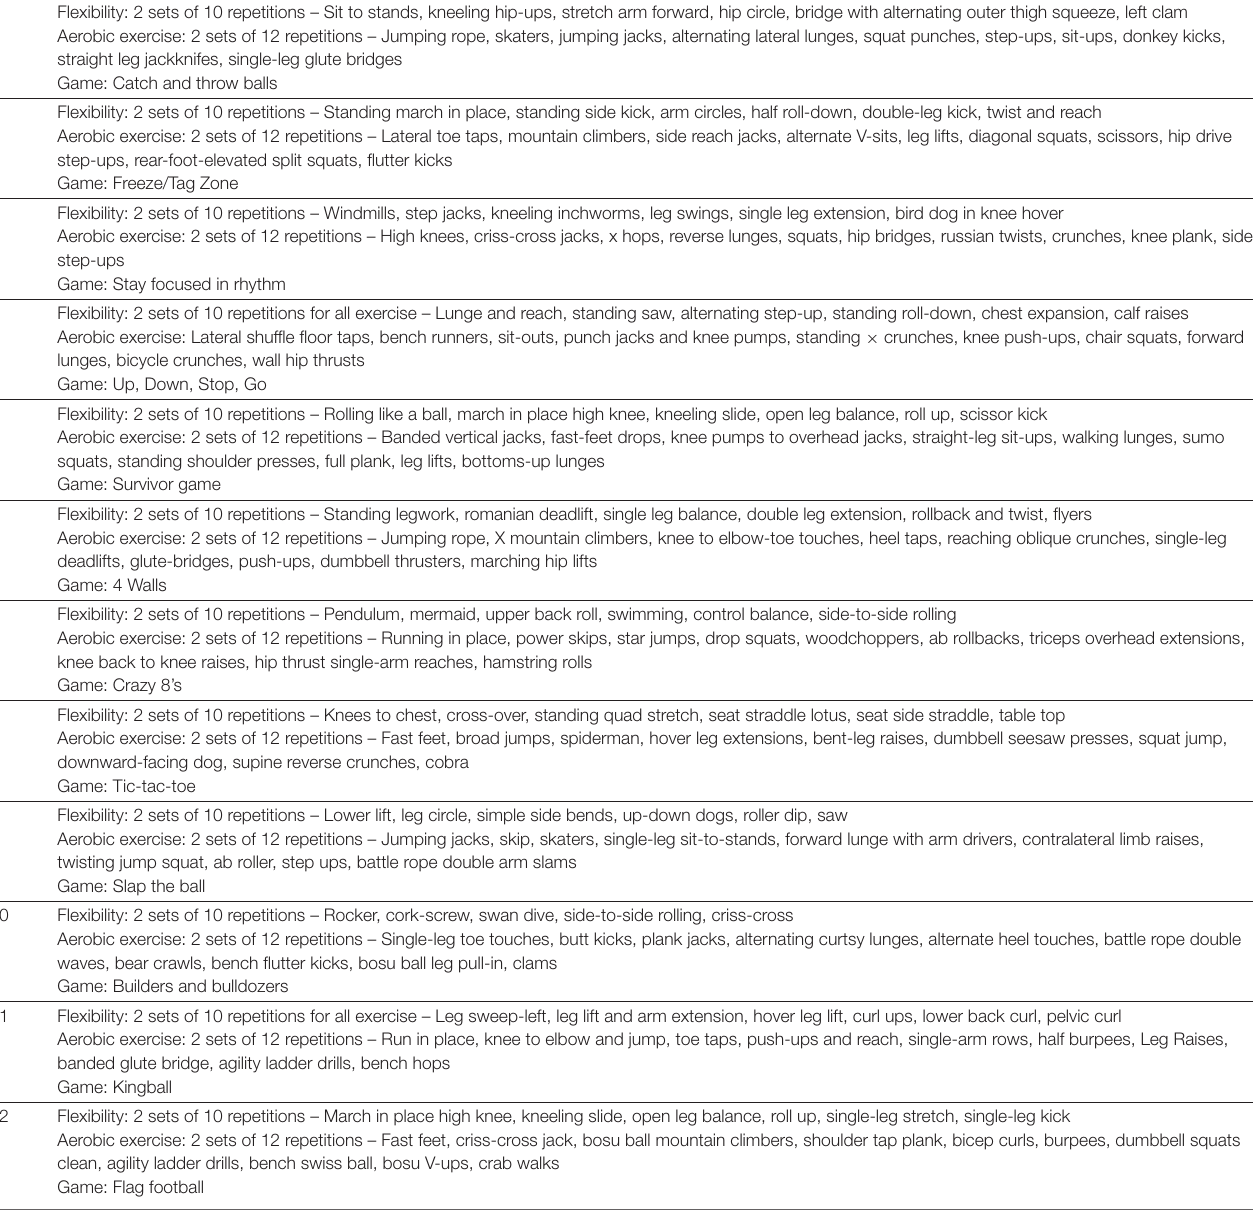
TABLE 1 | Weekly offered exercise sessions for the experimental group